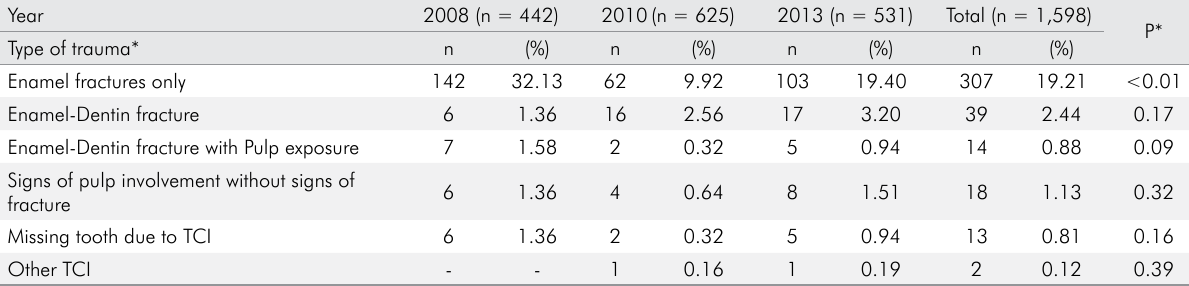
Table 2. Prevalence of each type of traumatic crown injuries by year. Santa Maria, Brazil.